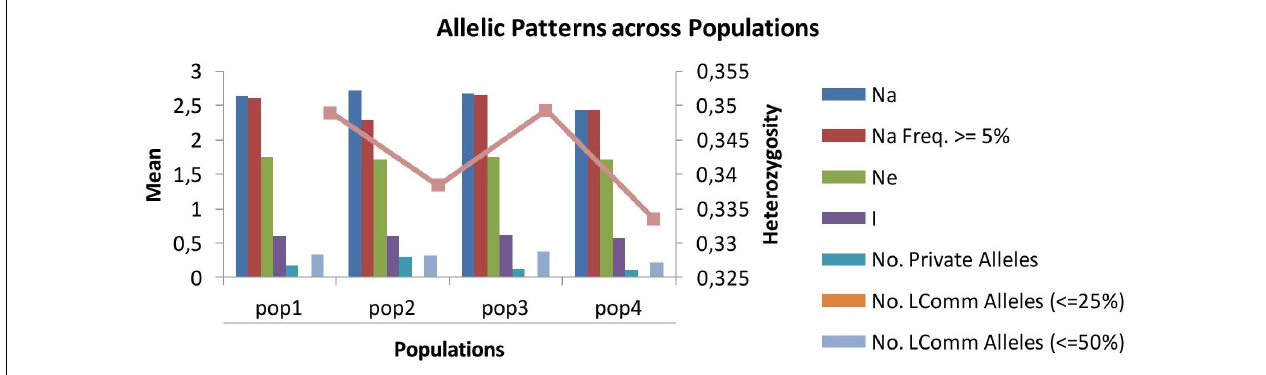
FIGURE 4 | Graphical presentation of allelic patterns across the